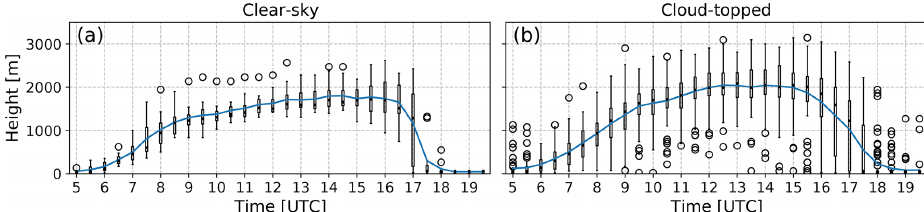
Figure 6. Composite of 30min mixing-layer height for (a) clear-sky days and (b) cloud-topped days. The blue line indicates the mean of mixing-layer height, the box denotes the upper quartile and lower quartile, and the whiskers show the extension of 1.5 times the interquartile range. The outliers are denoted by the